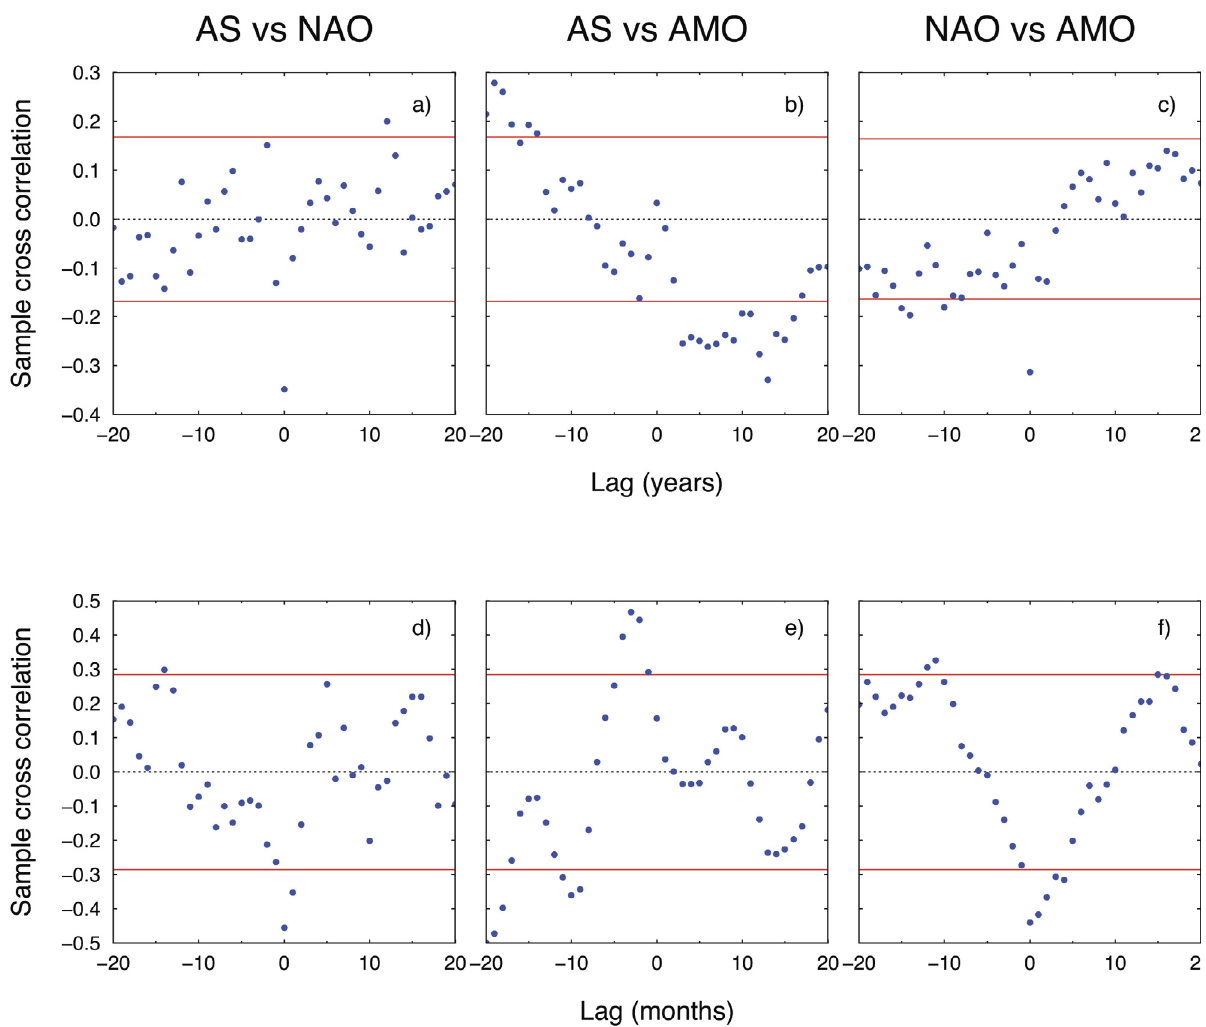
Figure 9. Sample cross correlation between AS, AMO and NAO (the 95% confidence intervals are denoted by red horizontal lines). Frames a), b) and c): whole period (1880-present) with annual data; d), e) and f): from 2009 with monthly